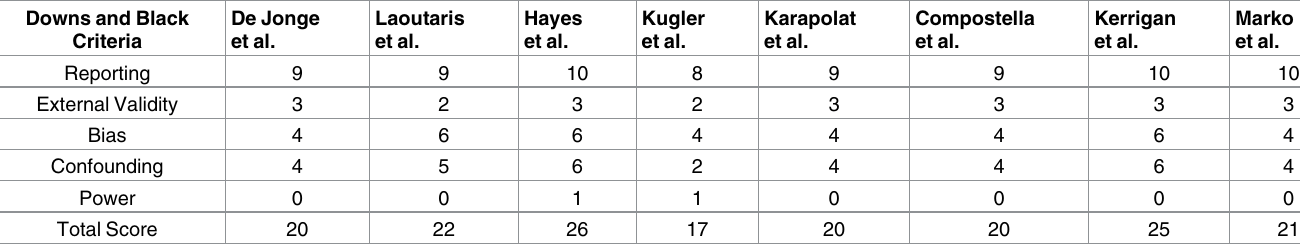
Table 2. Downs and Black quality assessmentscore. Downs and Black